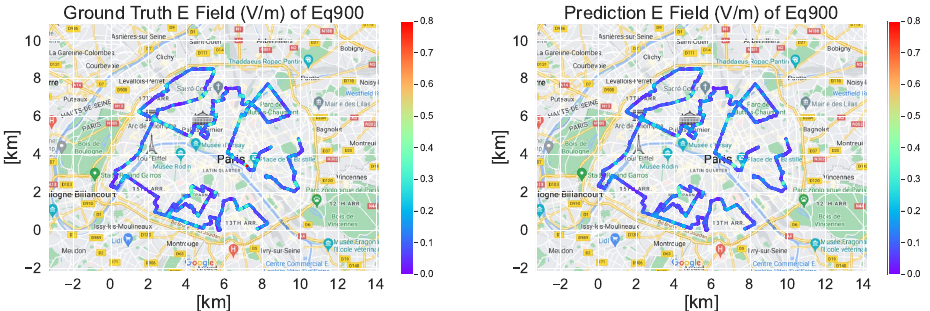
Figure 7. Ground truth ( left ) and prediction ( right ) of total Eq900 E-field prediction for N = 3 (and model b).